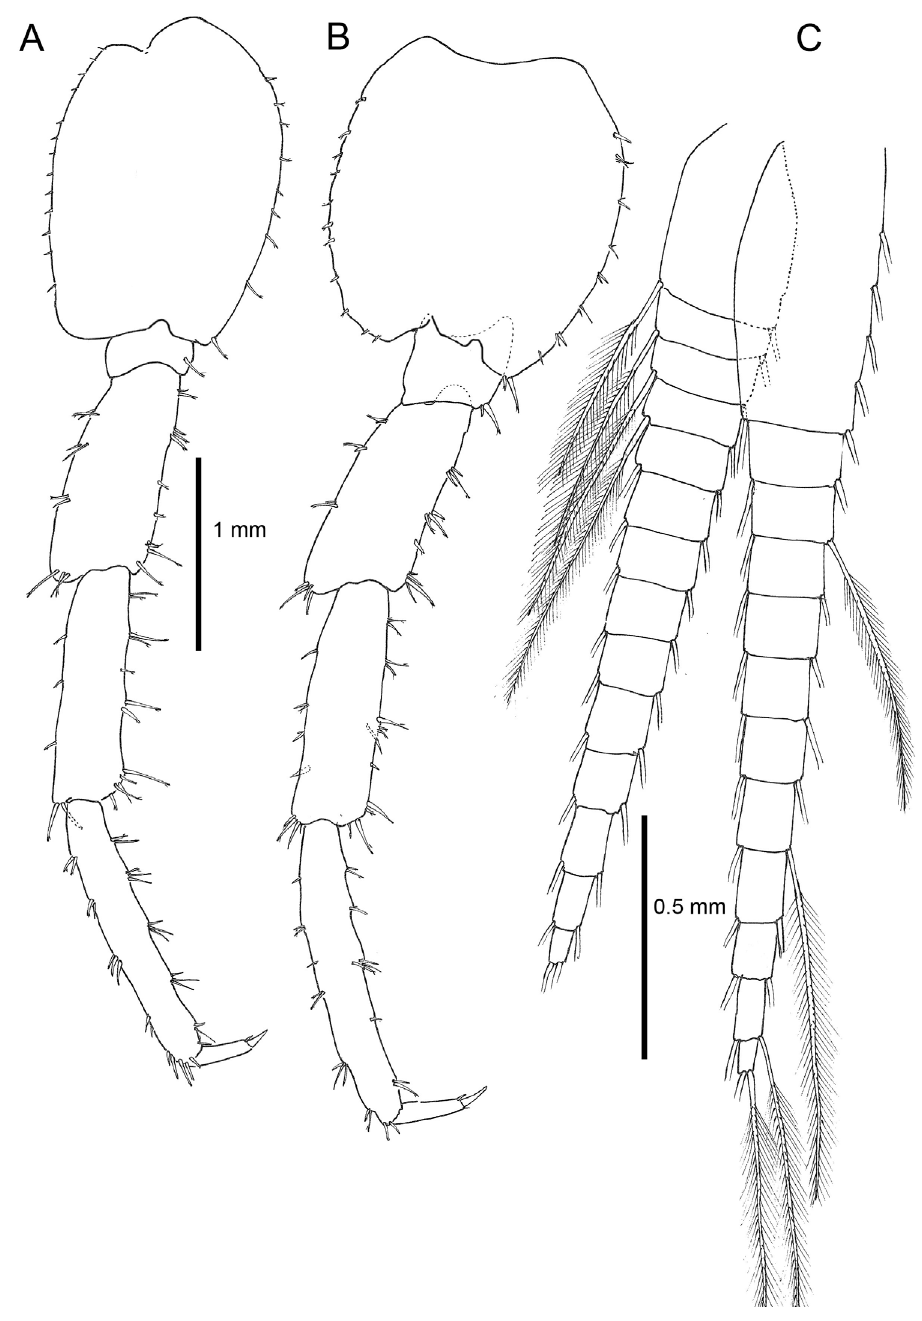
Figure 6. Cryptorchestia ruffoi sp. n., paratype male 10.4 mm (RMNH) A peropod 6 B pereopod 7 C pleopod